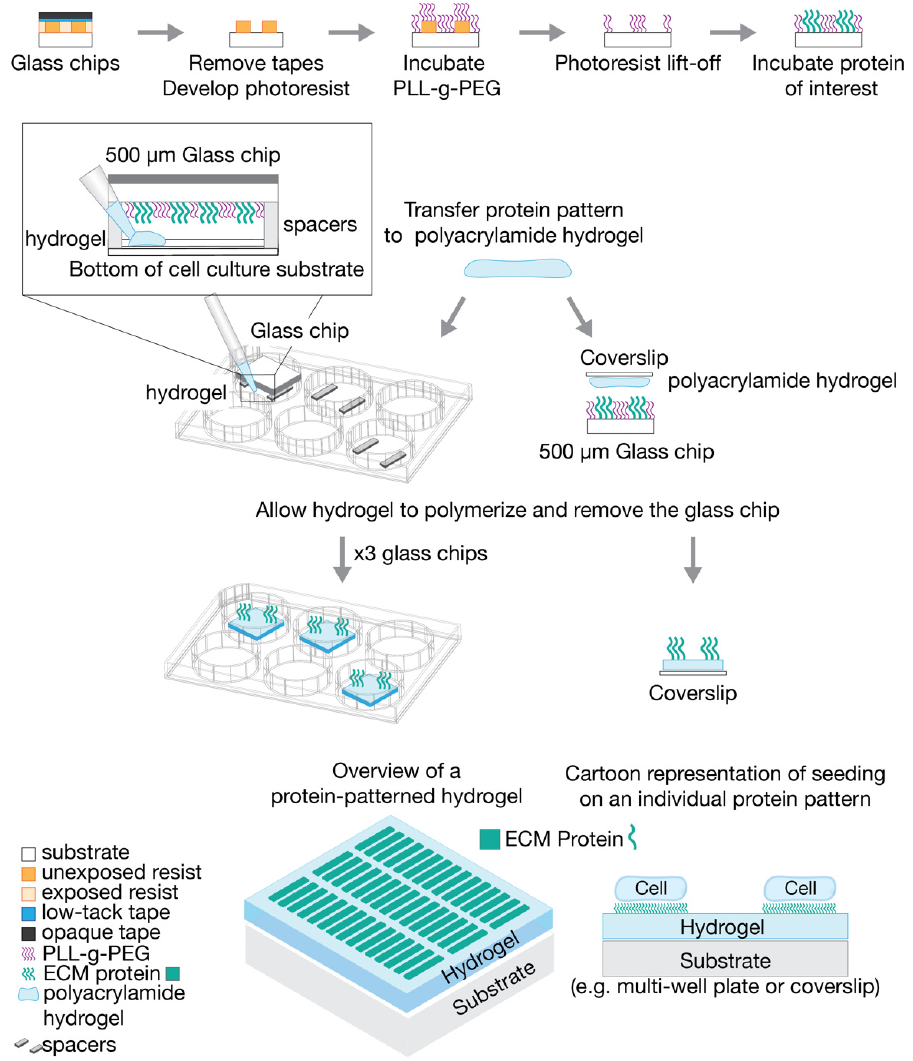
Figure 2. Protocol for generating protein patterns on diced glass chips from photoresist templates fer